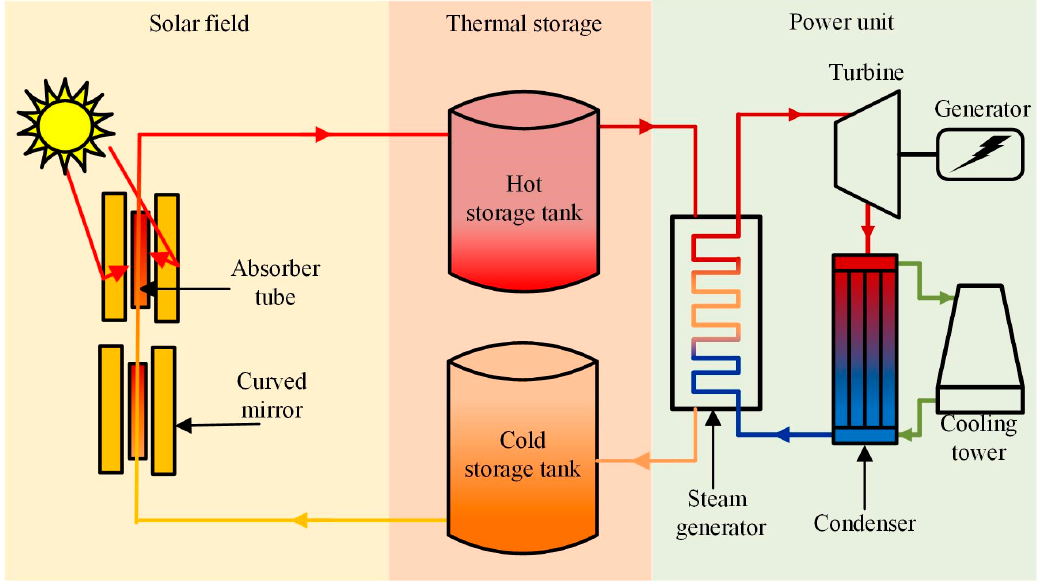
Figure 5. A schematic diagram of a linear Fresnel reflector (LFR) system.